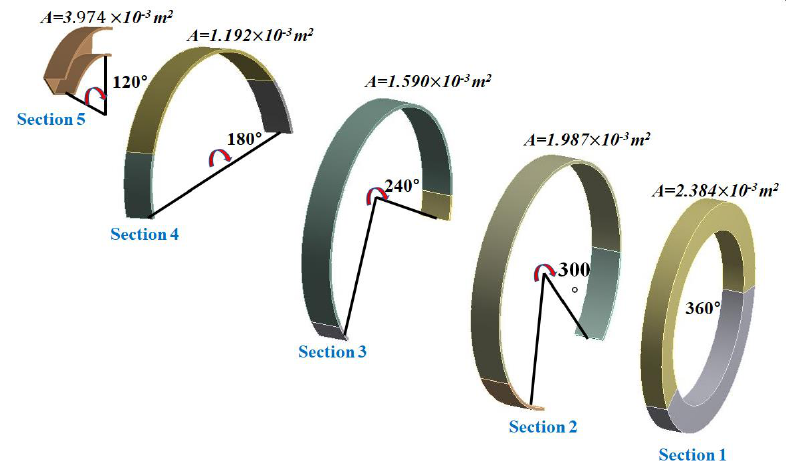
Figure 7. 3D sliced model for different condenser, Model